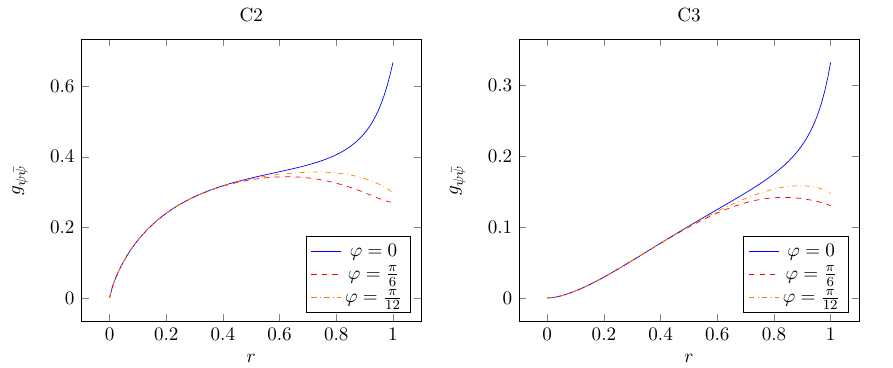
Figure 3 . Metrics for C2 (left) and C3 (right).